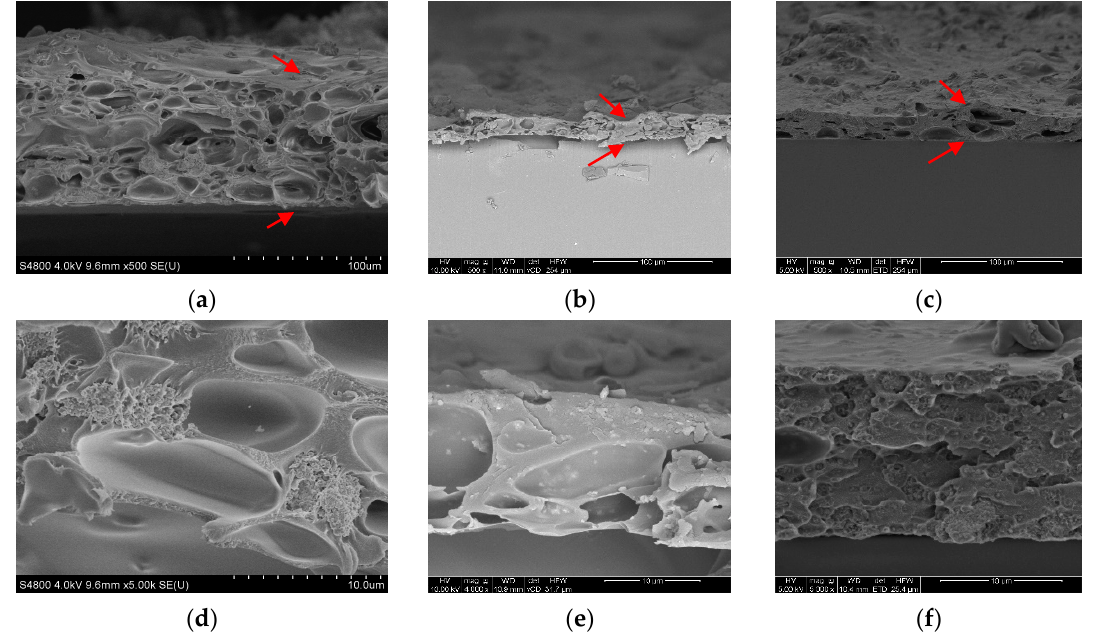
Figure 5. Cross-sectional structure of composite polyimide coatings with 10% ( a , d ), 20% ( b , e ) and 30% ( c , f ) alumina. Arrows indicate top and bottom surface of coatings.